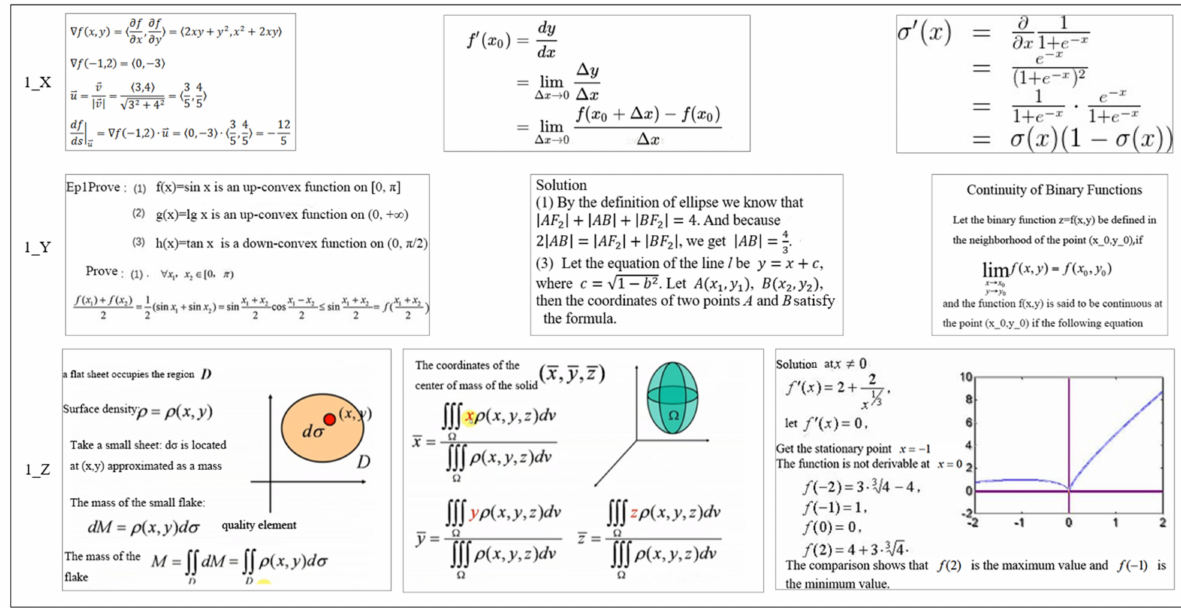
Figure 10. Examples of subcategories of images. The 1_X category represents an image that contains only mathematical formulas, the 1_Y category represents an image that contains both text and mathematical formulas, and the 1_Z category represents an image that contains both text, coordinate maps and